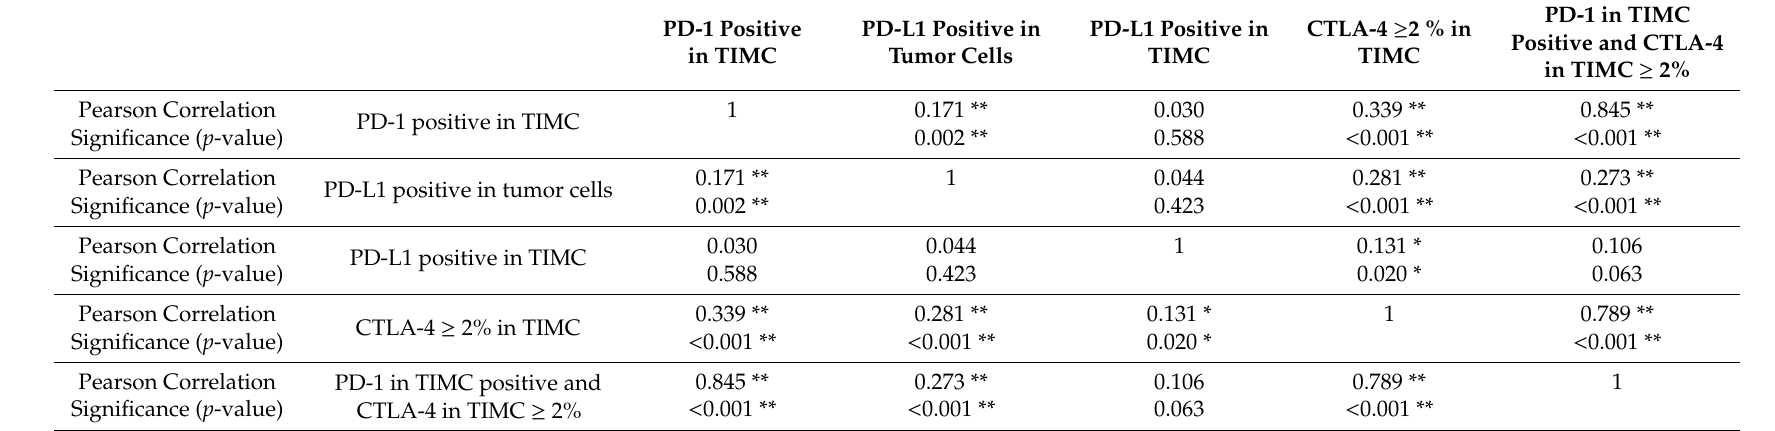
Table 2. Non-parametric correlation of PD-1, PD-L1, and CTLA-4